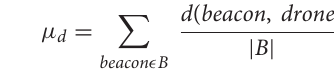
recognition NUI was located in front of the participant’s right hand, and a white panel covering the whole view of the webcam color contrast. The Pupil Core goggles were worn by the user as normal eyeglasses. The experimenter sat on the left side of the table and operated the computer controlling the whole system through